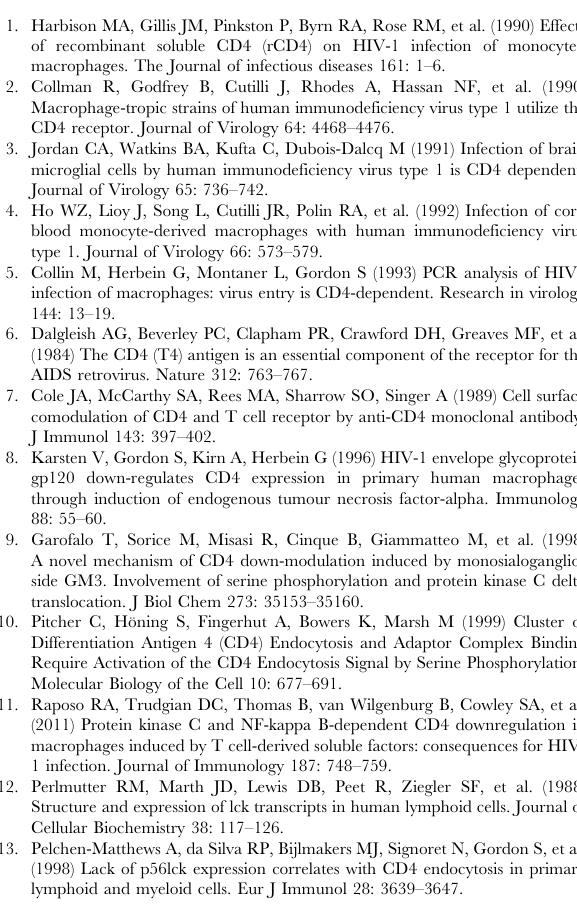
OX-68 (orange line, right panel, recognises chimeric CD4